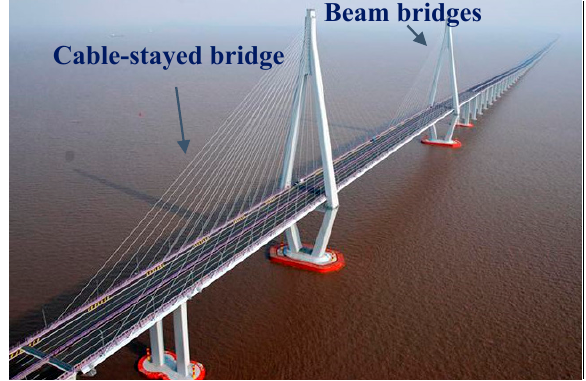
Figure 1. Overview of the cable-stayed bridge and beam bridges.